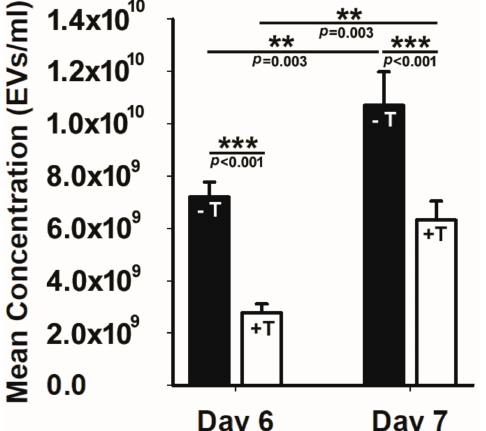
Figure 2. Loss of the primary cilia significantly reduced EV production. The solid black bars at days 6 and 7 post vehicle ( − T) or tamoxifen treatment (+T) treatment reveal that cells treated with tamoxifen that lose their primary cilia exhibit a significant reduction in EV production. ** p < 0.01, *** p <